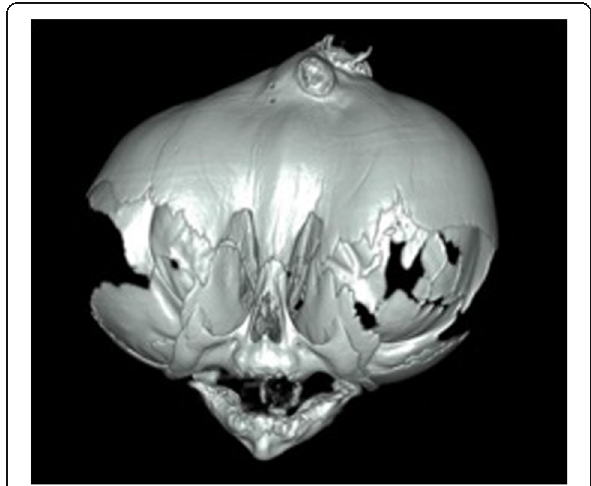
Fig. 3 3D reconstruction imaging of the